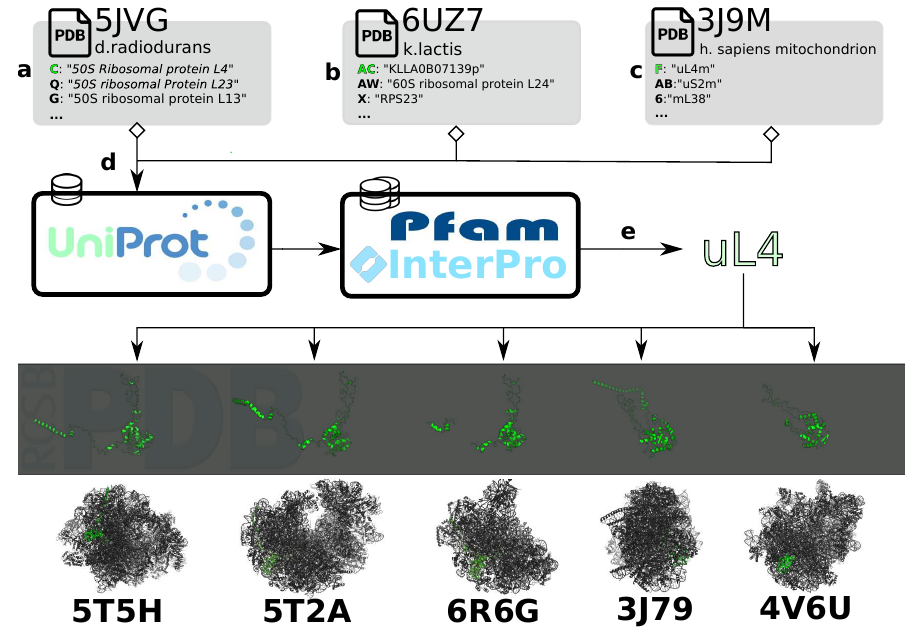
Figure 3. Processing of data and annotations for comparison of the ribosome across structures. ( a – c ) Subchain annotations in a .mmcif/.pdb file are heterogeneous and have to be converted to a